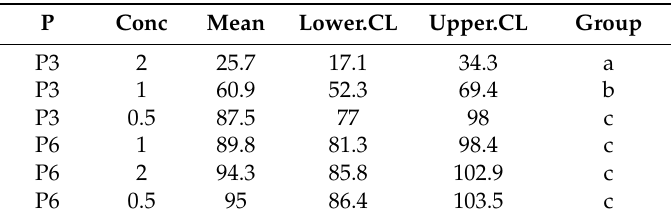
Table 5. As the interaction was significant, simple effects were compared. Means with the same letter are not significantly different.